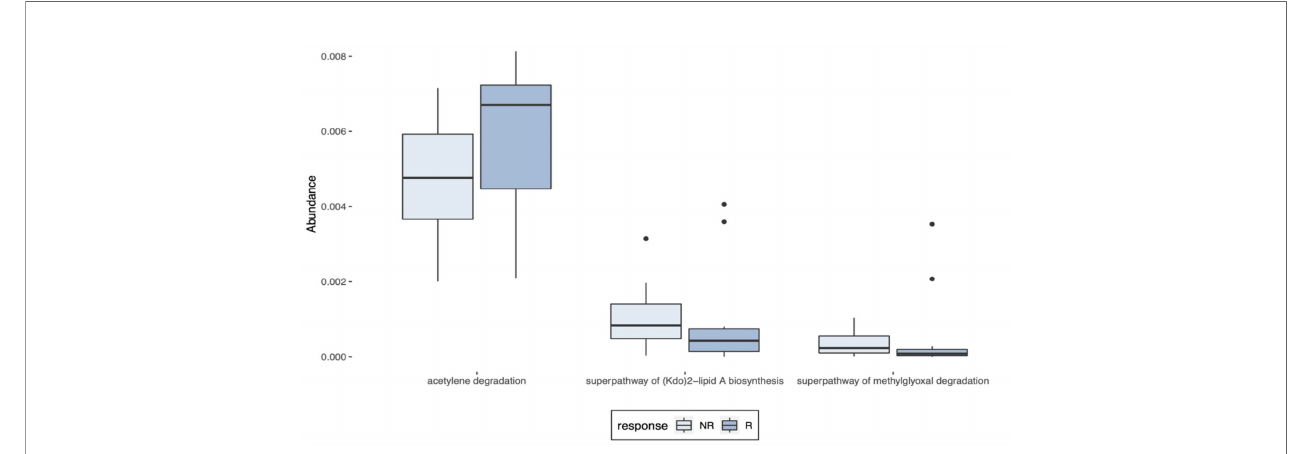
FIGURE 7 | Predictions of the metagenomes identi fi ed in LARC biopsy samples. PICRUSt predictions of the metagenomes previously identi fi ed as differentially abundant in pre-treatment LARC biopsies between R and NR patients as identi fi ed by LEfSe (LDA score ≥